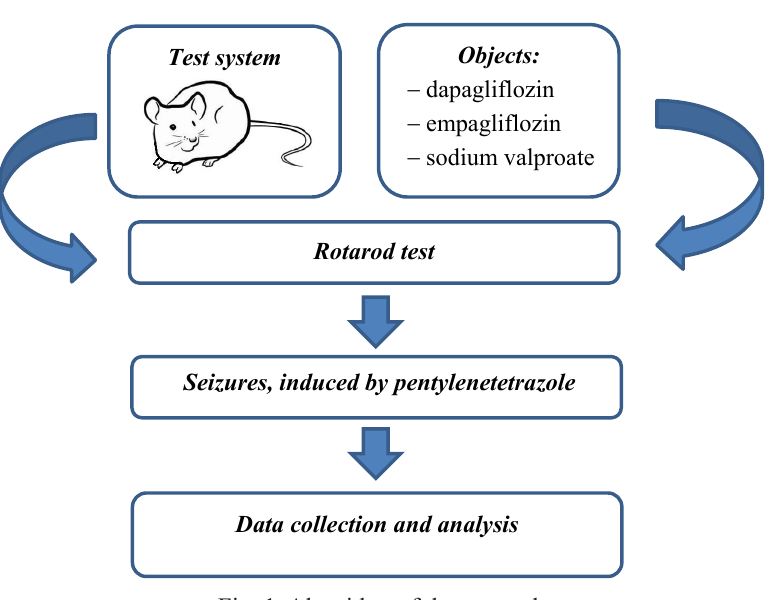
Fig. 1. Algorithm of the